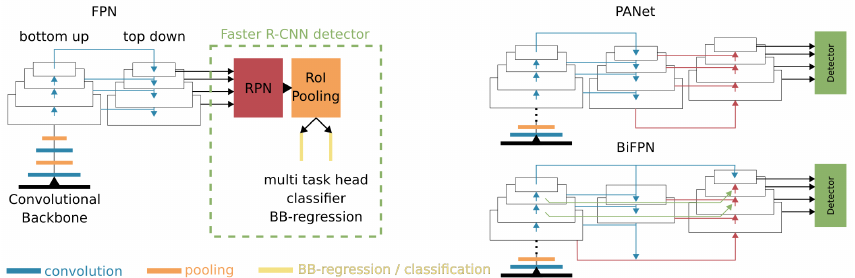
Figure 13. Conceptual overview of Feature Pyramid Network (FPN) and its variants. In the original FPN [77] (left), the last layers of the convolutional backbone (bottom up path) are paired with a top down path which uses the bottom up feature layers to enhance the semantic high level information with precise localisation. Prediction of region proposals is then done on the different layers of the top down feature pyramid. The two variants Path Aggregation Network (PANet) [82] and bidirectional FPN (BiFPN) [93] enhance the structure with an additional bottom up path (red arrows) and intra-scale skip connections (green arrows),